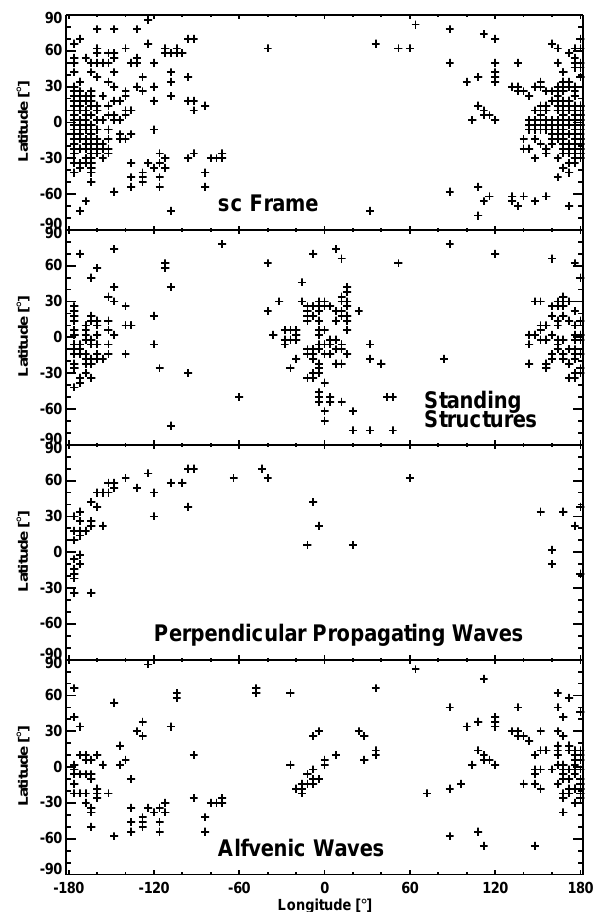
Fig. 14. Spatial distribution of the wave vector directions in the spacecraft frame (top), of standing structures (second panel), of perpendicular propagating wave (third panel) and of Alfv´enic wave events (bottom) in the plasma rest